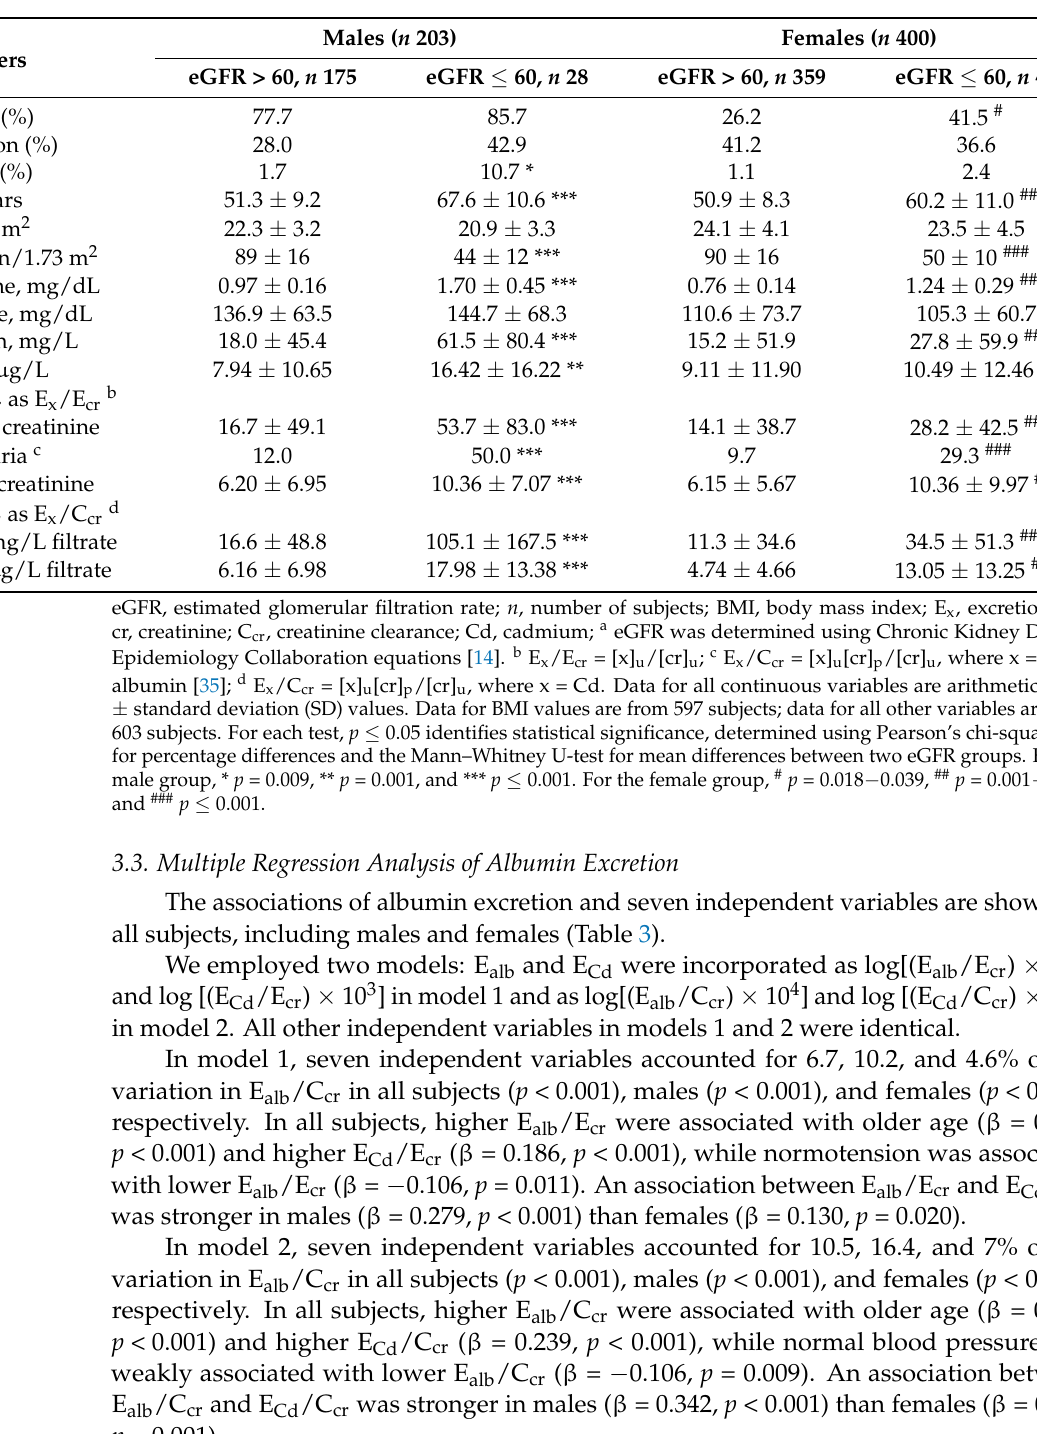
Table 2. Characterization of study subjects according to sex and eGFR